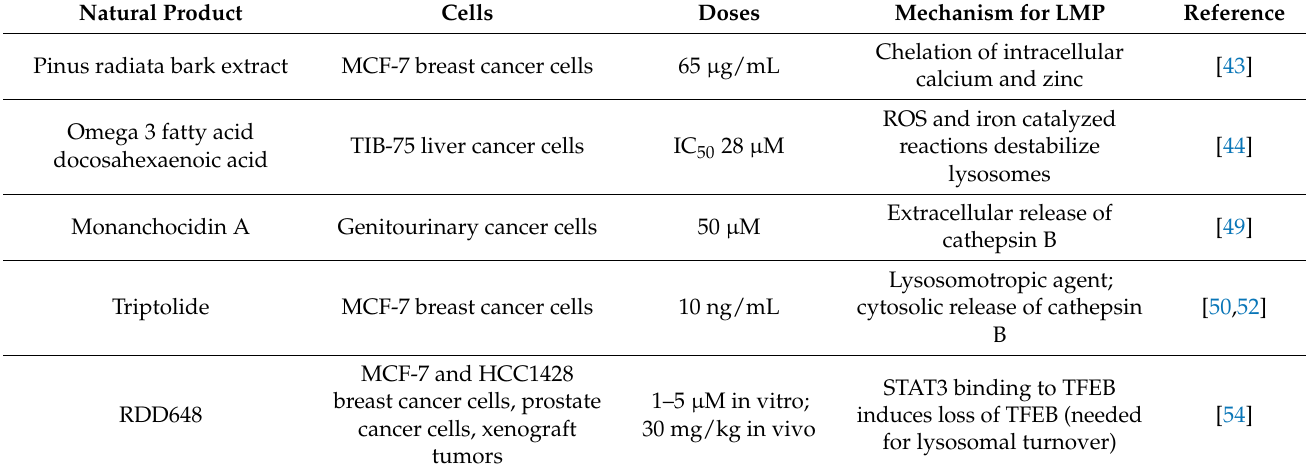
Table 1. Natural products with anticancer properties related to lysosomal membrane permeabilization. Natural